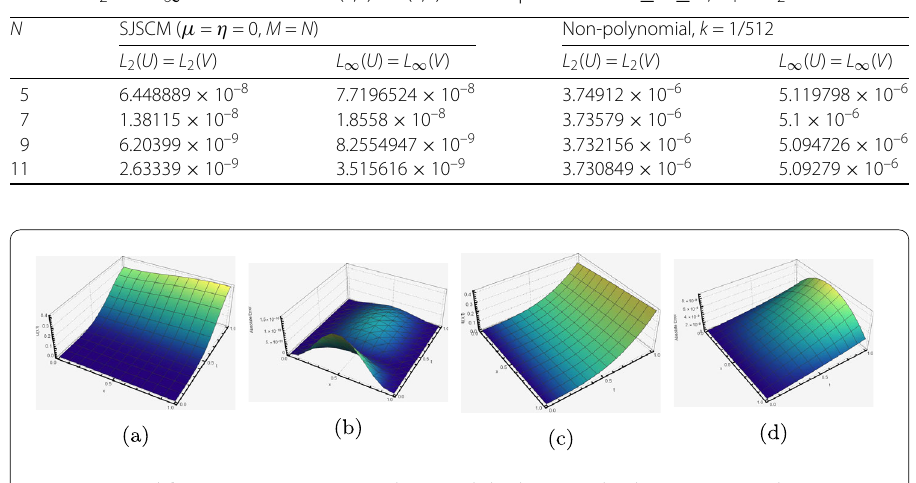
Figure 7 ( a ) and ( b ) represent approximate solution and absolute error distribution, respectively, using SJSCM. ( c ) and ( d ) represent approximate solution and absolute error distribution, respectively, using